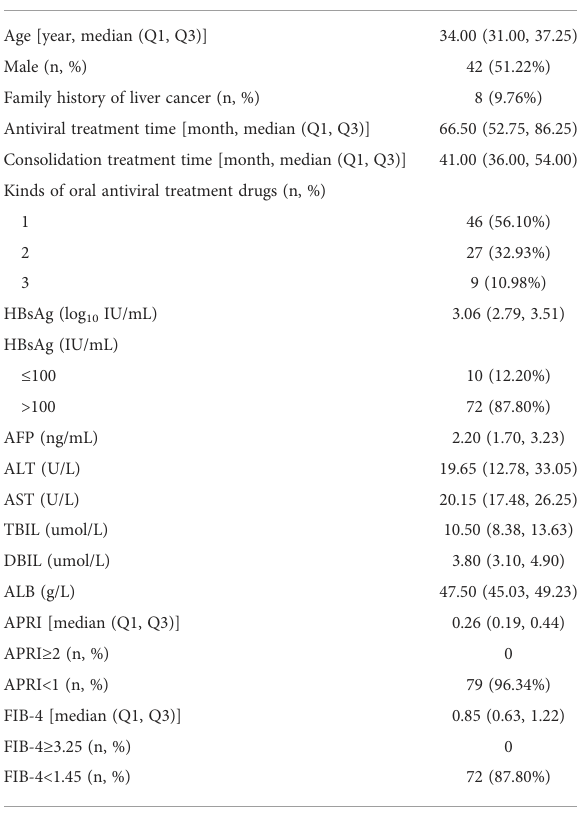
TABLE 1 Baseline characteristic of the